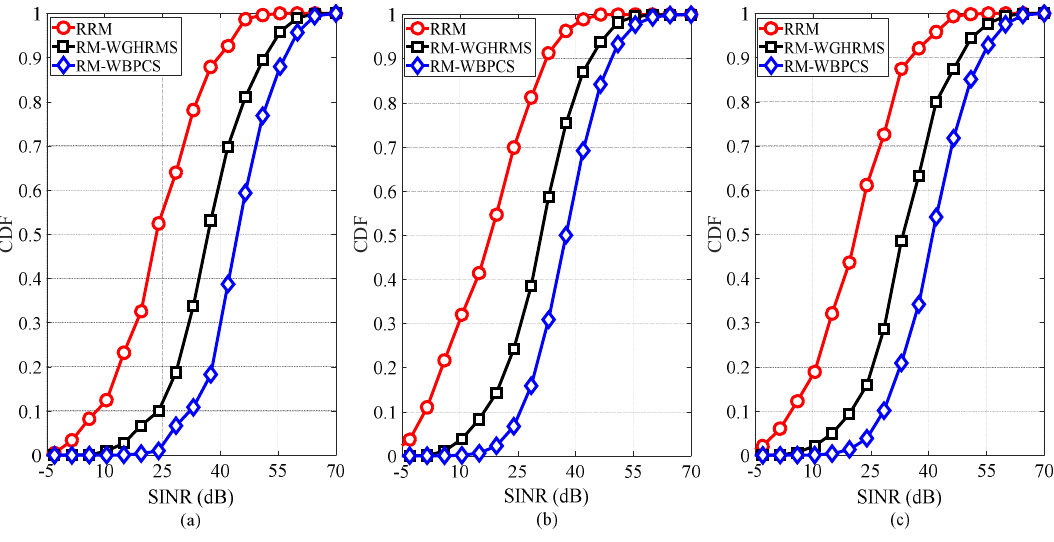
Figure 4. CDF of the SINR for ( a ) DPs, ( b ) CUs, and ( c ) the overall system.